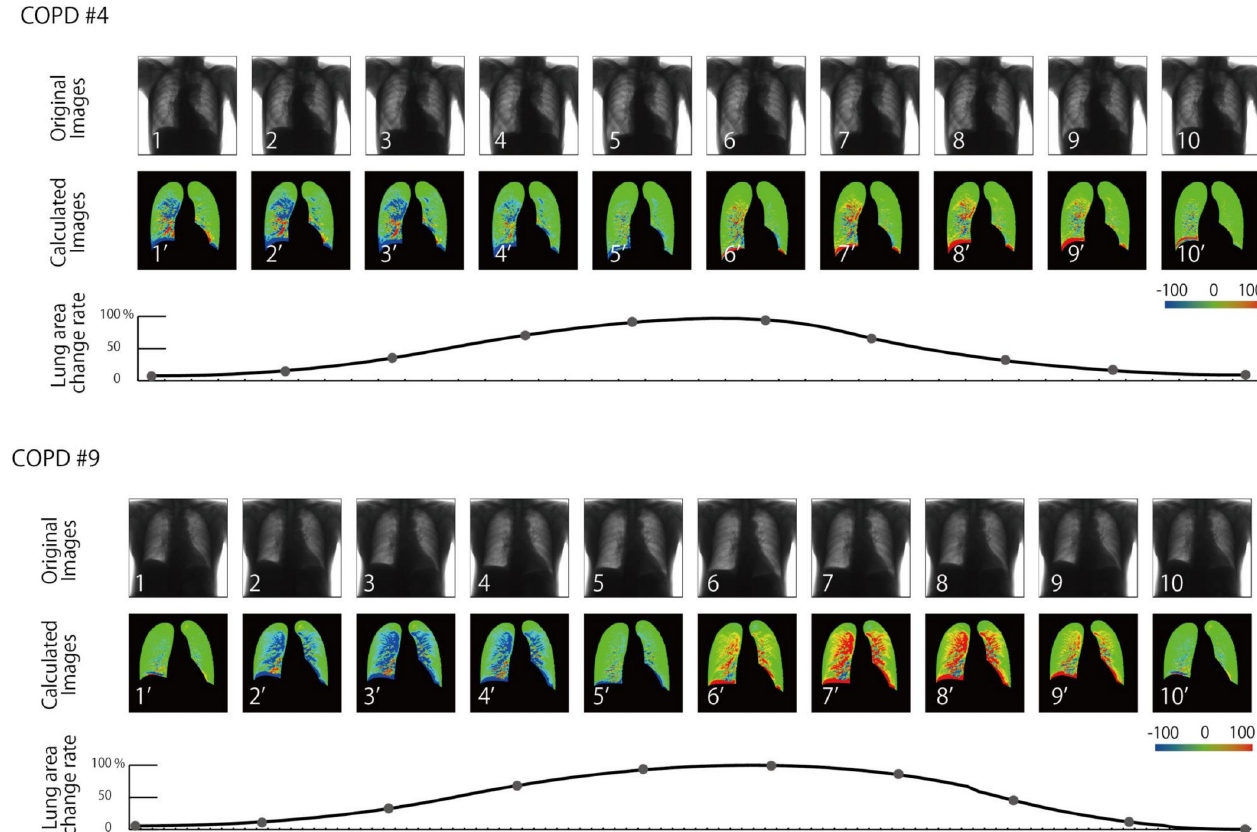
Fig 6. Generated dynamic images of patients with COPD (#4 and